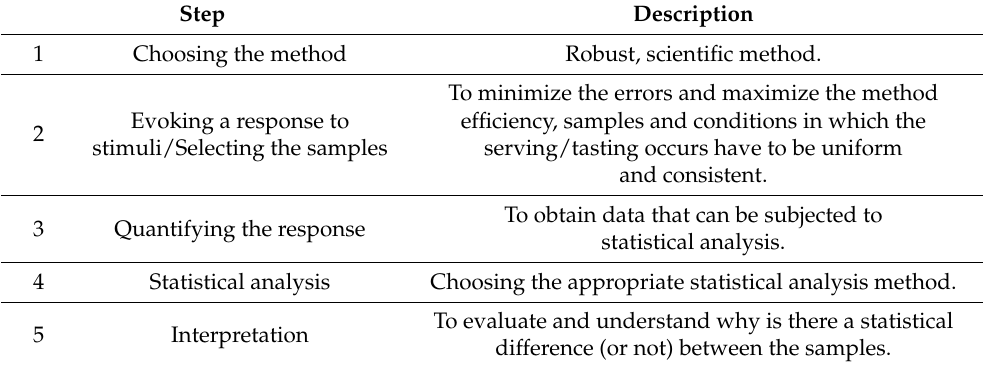
Table 1. Basic steps of sensory analysis adapted from